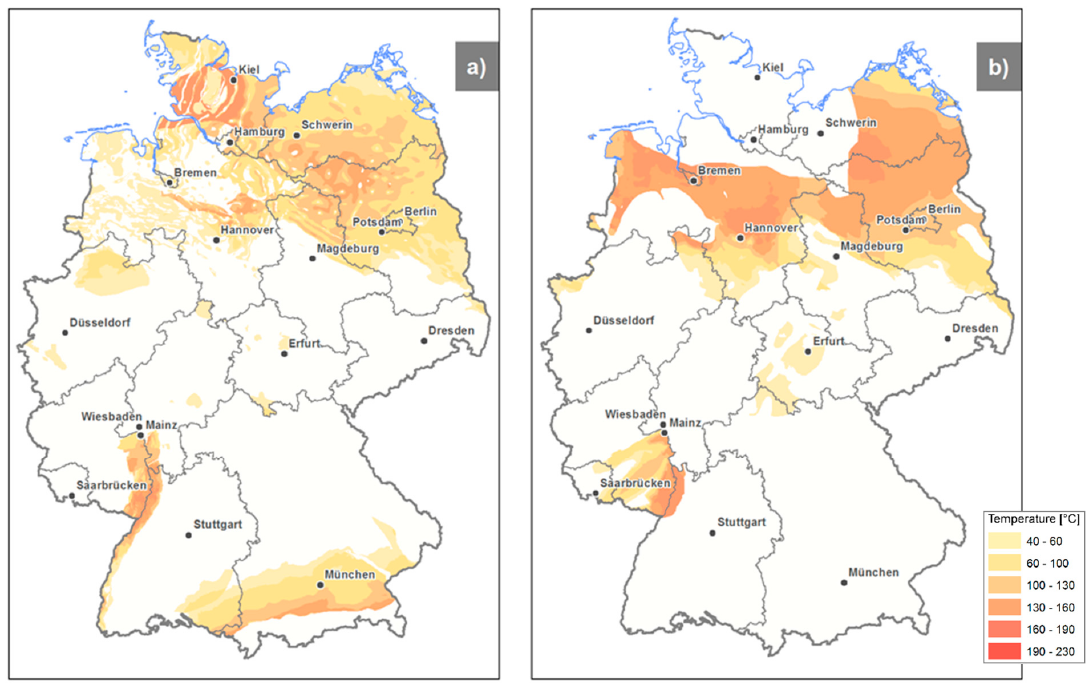
Figure 1. Maps of the Geothermal Atlas of Germany [20] for measured ( a ) and inferred/indicated ( b ) hydrothermal resources and associated maximum temperatures.